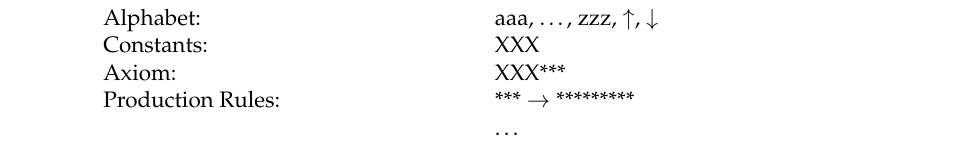
Table 9. L-systems construction for generating 2D gripper encodings. The L-system is constructed with an alphabet, including letter encodings for each of the single units or multi-unit group ([aaa, ..., zzz]), then two characters to indicate the orientation of the succeeding unit ( ↑ and ↓ ). A starting point (XXX) is added as a constant to identify the global location of the assembly and the fixed boundary condition. The axiom starts with the starting point constant, followed by a random three-character code from the alphabet.